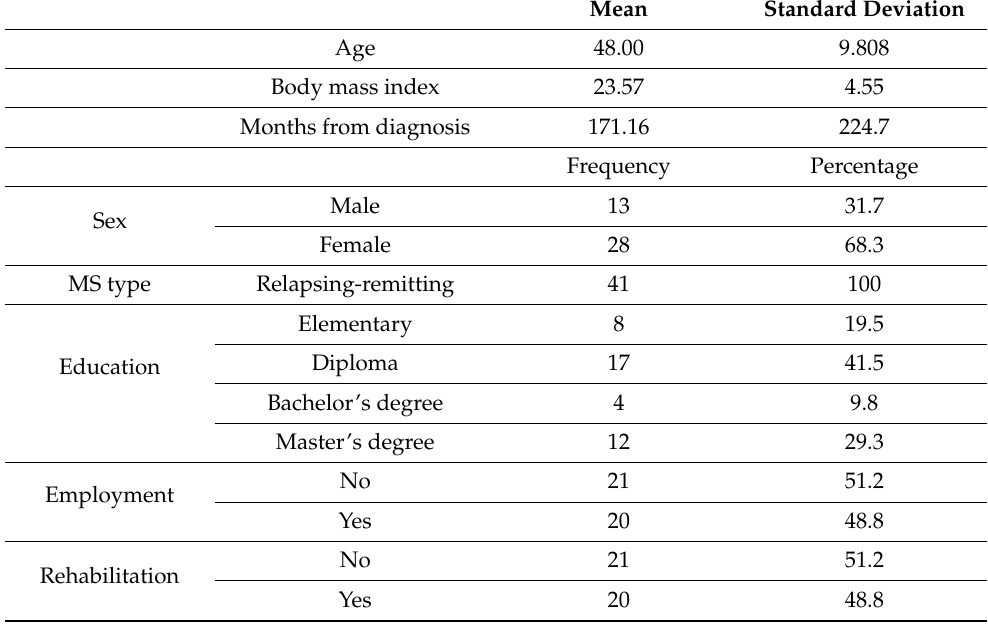
Table 1. Patient demographic